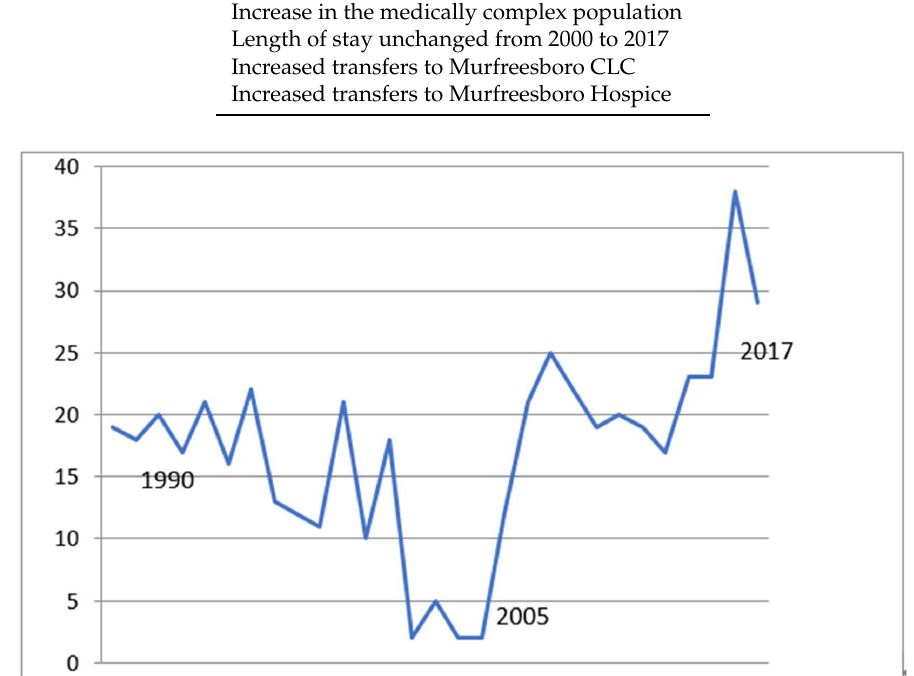
Figure 1. Discharge to long-term care (%). Mean % discharge to LTC (1987–2005) 13.5% (SD 3.6),